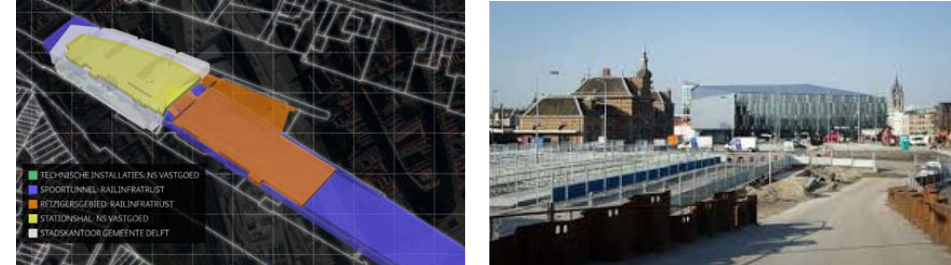
Figure 2. The building complex of Delft station, with (left) the property rights situation and (right) a picture of the situation above ground.